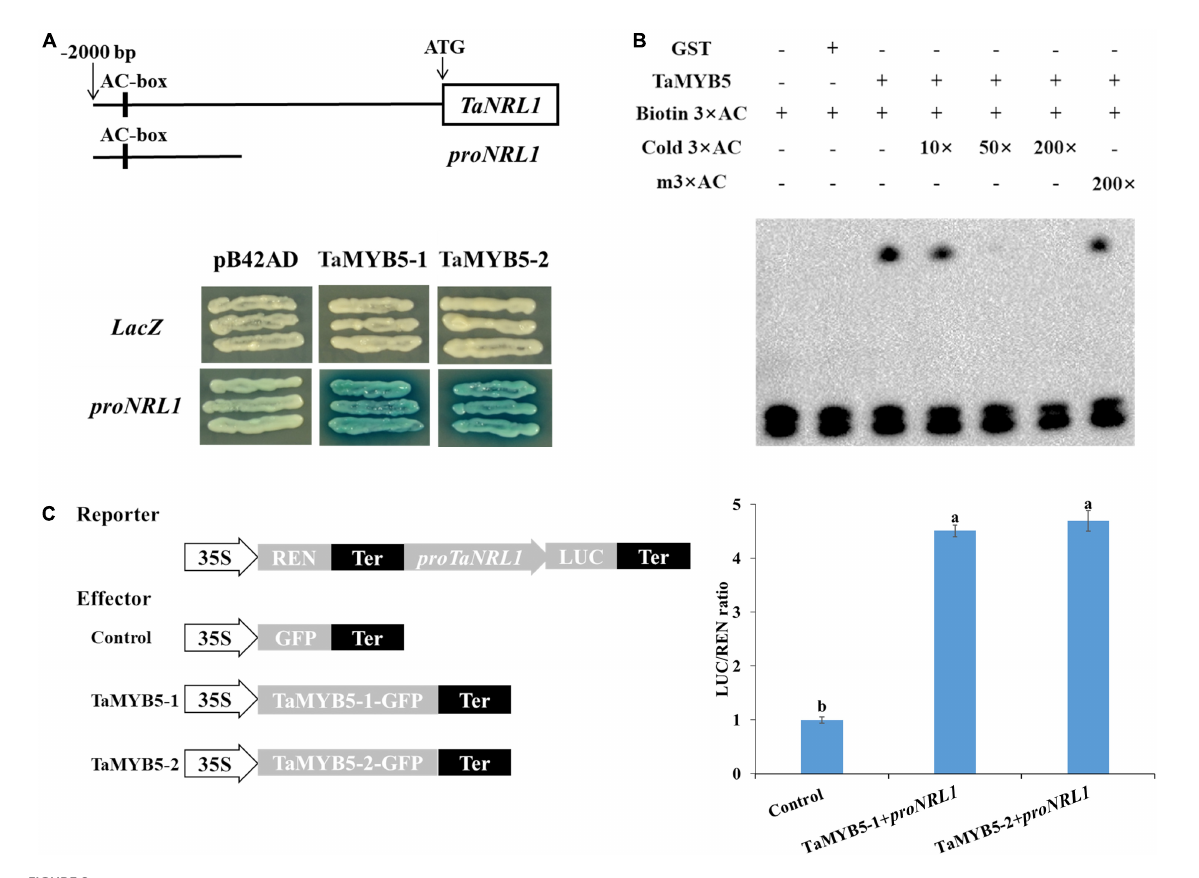
FIGURE8 TaMYB5 binds to the wheat TaNRL1 promoter region. (A) TaMYB5 activated expression in yeast of the LacZ reporter gene driven by the AC box of TaNRL1 promoter. proNRL1 are base pairs from 1,150 bp to 2,000 bp in the promoter of TaNRL1 . LacZ and pB42AD were used as negative controls. TaMYB5-1 and TaMYB5-2 correspond to SNP -3A-1 and SNP -3A-2 amino acid sequences, respectively. (B) EMSA (electrophoretic mobility shift assay) of the TaMYB5-GST protein and the AC box probe. The lower bands show the free probes and the upper bands show that the TaMYB5-GST protein binds to the biotin-labeled AC box probe. (C) Dual-luciferase assay of transformed tobacco leaves to detect the interaction between TaMYB5 and the proNRL1 . Schematic diagrams of the effector and reporter constructs are shown. Data are means ( ± SE) of three biological